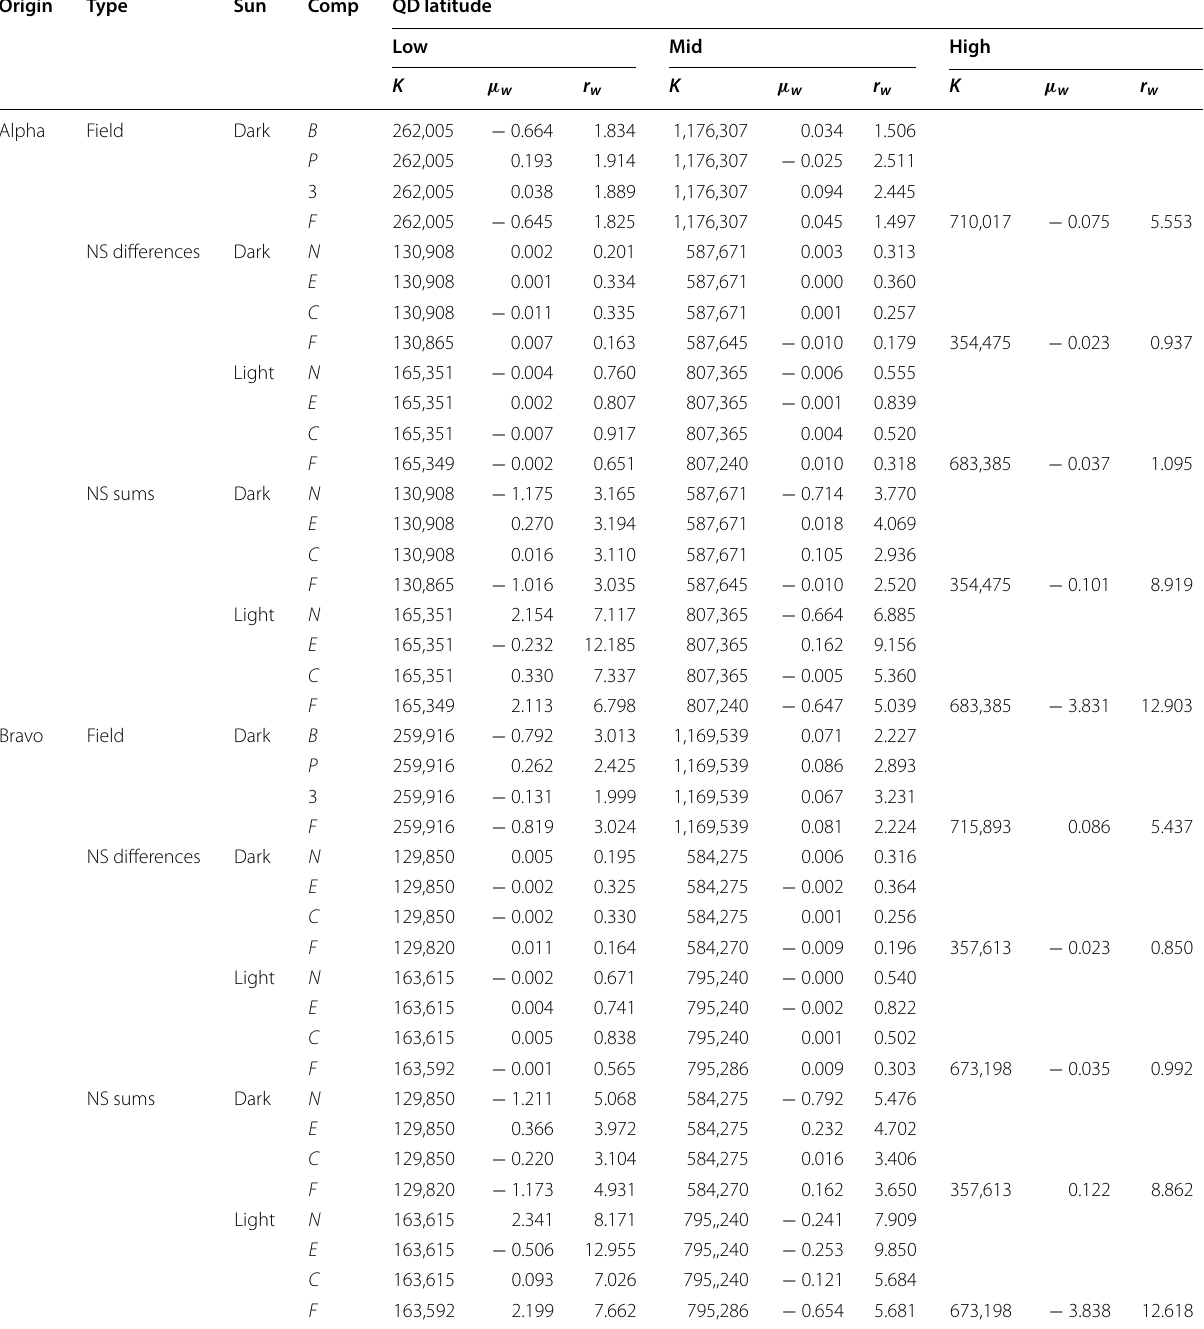
The µ w and r w are in units of